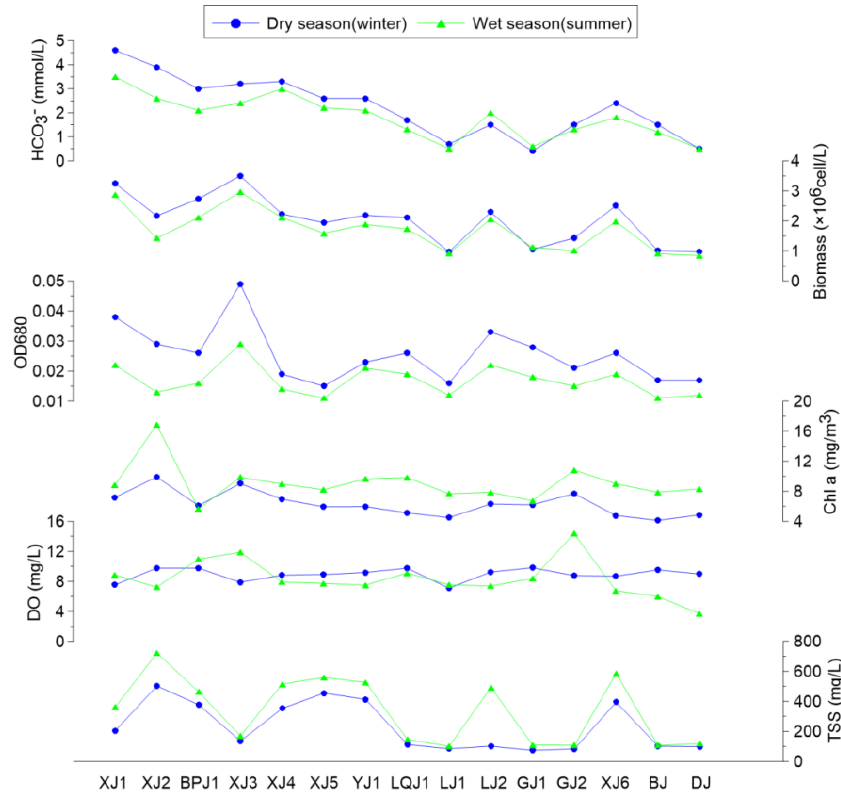
Figure 3. Characteristics of phytoplankton in water samples in the Pearl River basin.